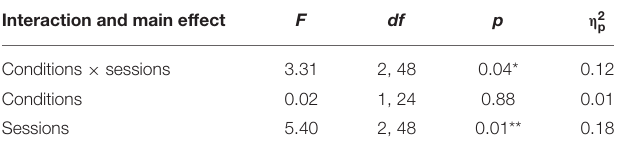
TABLE 4 | Results of ANOVA for